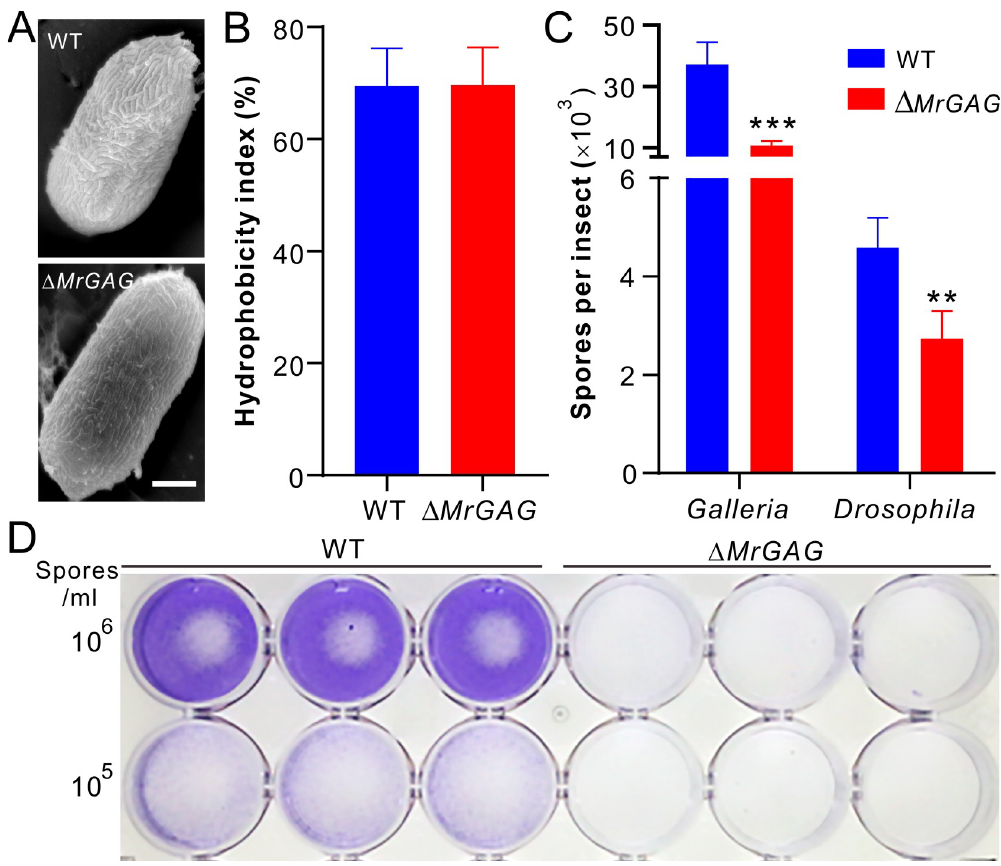
Fig 5. Conidial hydrophobicity and adhesion assays. (A) SEM observation of the WT and mutant conidia. Bar, 2 μ m. (B) No difference of the conidial spore hydrophobicity between WT and Δ MrGAG . (C) Variation of the spore adhesion abilities between WT and Δ MrGAG toward different insects. The spores were washed off and counted eight hours post treatment. The significance of the two-tailed Student’s t -test difference is at: ��� , P < 0.001; �� , P < 0.01. (D) Variation of the spore adhesion ability between WT and Δ MrGAG toward hydrophobic surface. Different concentration of spore suspensions were inoculated into the 24-well plate for 24 hrs and then washed off with PBS buffer. The wells were stained with crystal violet before